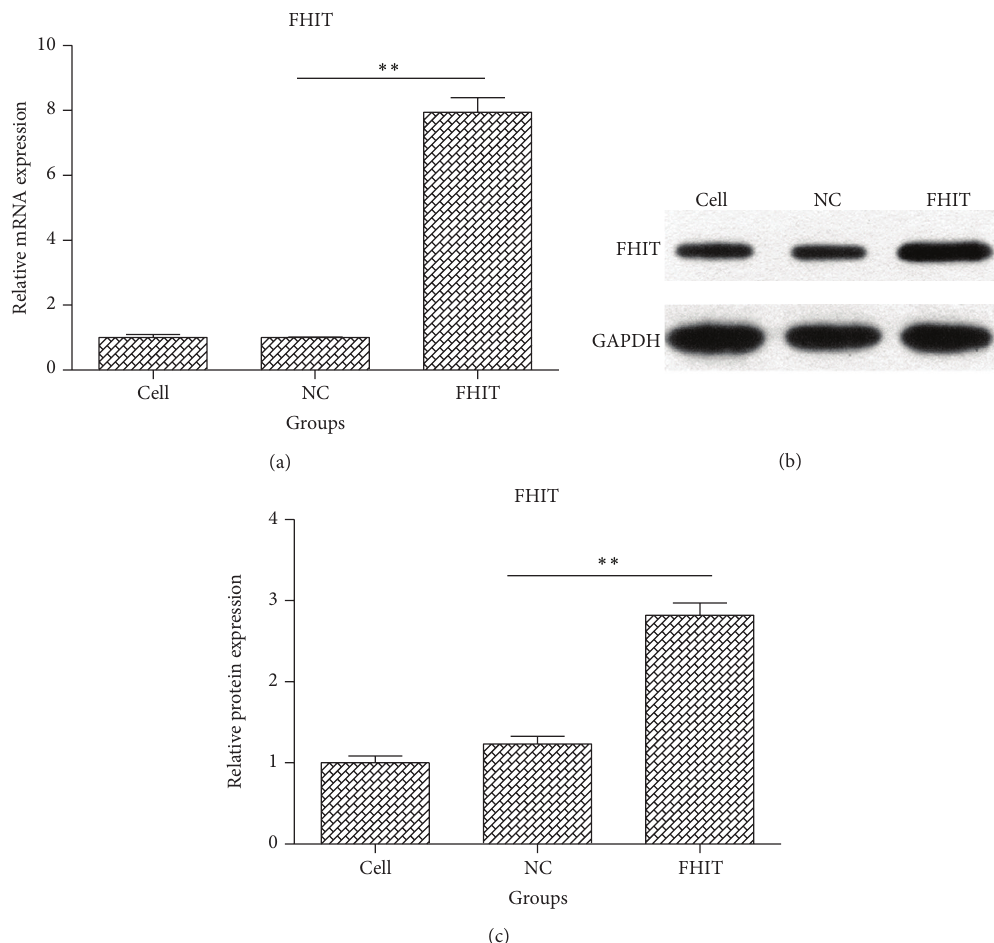
Figure 1: The expression of FHIT in QBC939 cells after transfection. (a) The expression of FHIT was assessed in each group after transfection using quantitative real-time RT-PCR. (b) Western blotting for FHIT protein expression. (c) Quantification of FHIT protein expression in each group presented in bar graphs as fold-increase. ∗∗ 𝑃 < 0.01